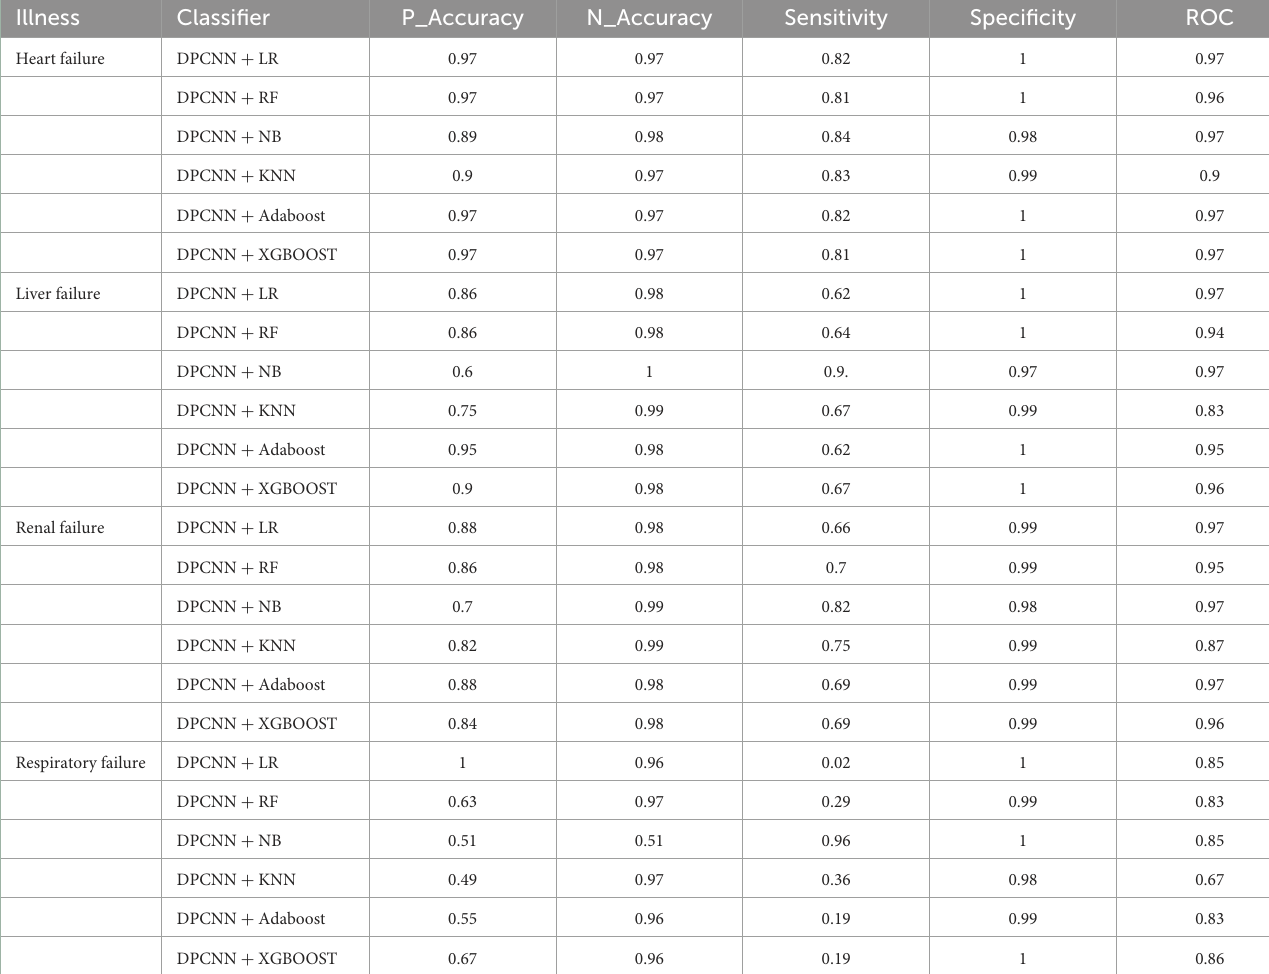
TABLE 5 Unstructured data experiments results.